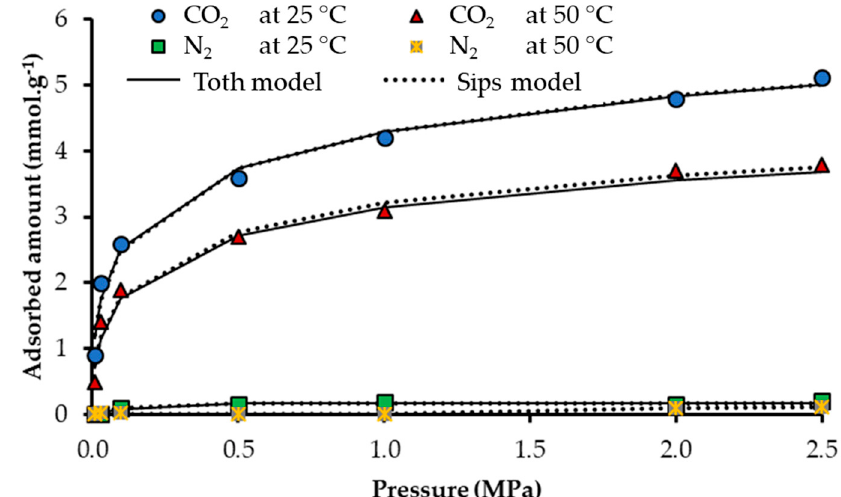
Figure 5. Adsorption isotherms for CN.RON2 at different conditions: 25 and 50 °C for CO 2 and N 2 , and the fitting of Sips and Toth models. Pressure up to 2.5 MPa.